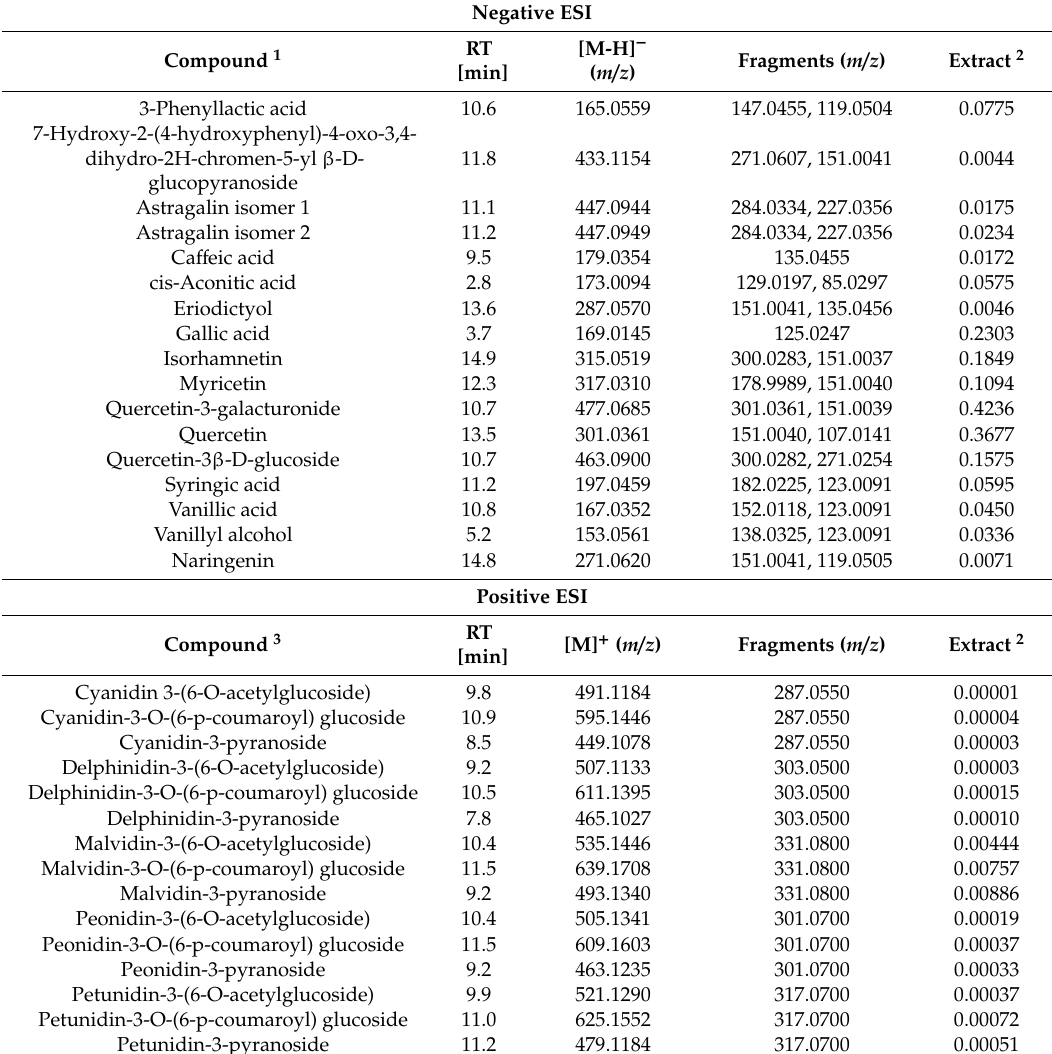
Table 1. Data on identification of phenolic compounds composing the multifunctional extract from Tannat grape skin obtained under hydro-alcoholic-acid conditions analyzed by UHPLC-MS /